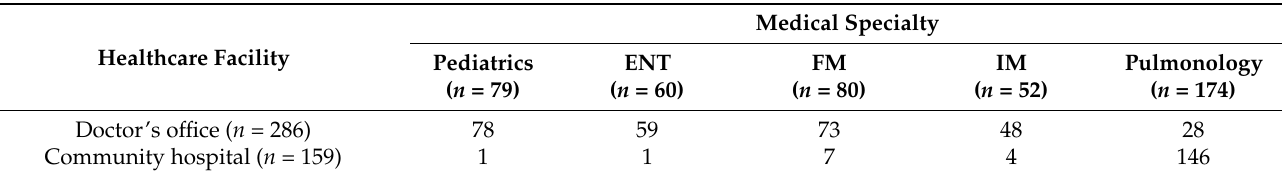
Table 1. The medical specialty and healthcare facility of participating physicians.